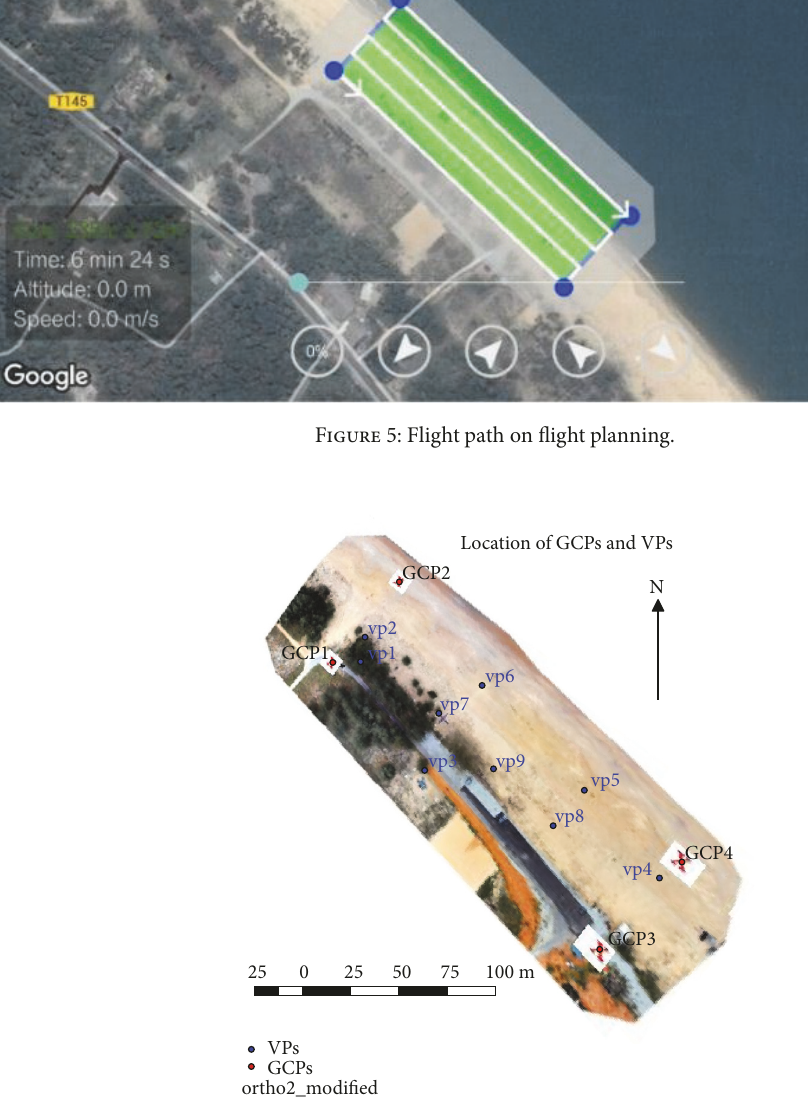
Figure 6: The location of GCPs and